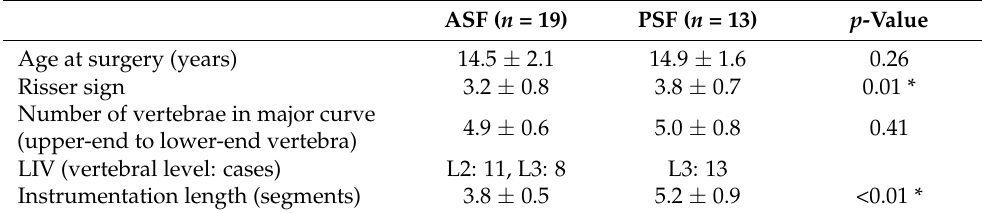
Table 6. Demographic data of cases with ≥ 32 mm of preoperative LIV translation from CSVL.